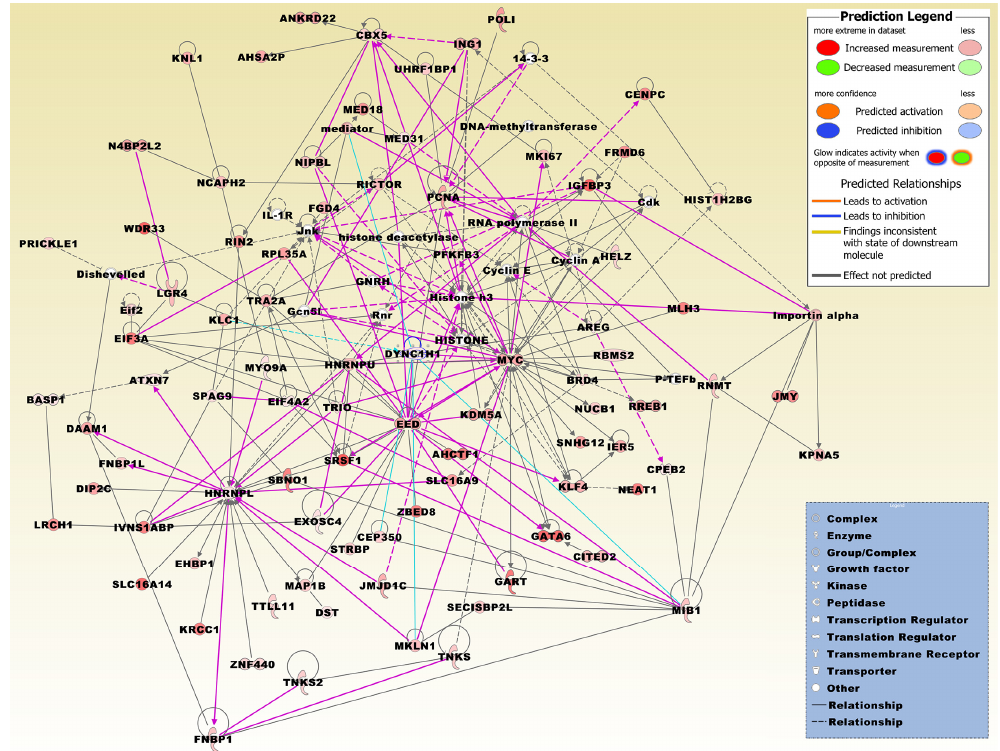
Figure 4. The merged network is based on the top three networks that were most significantly related to the microarray expression profiles of the set of 411 DEGs, which were both up- and down-regulated in at least two different conditions. Network molecules were related to, e.g., post-transcriptional and post-translational modification, DNA replication, recombination, and repair, cell-to-cell communication, cancer and other abnormalities, cellular growth, and carbohydrate metabolism (Table 2). Molecules derived from the 411 DEG set include AHCTF1, AHSA2P, ANKRD22, AREG, ATXN7, BASP1, BRD4, CBX5, CENPC, CEP350, CITED2, CPEB2, DAAM1,